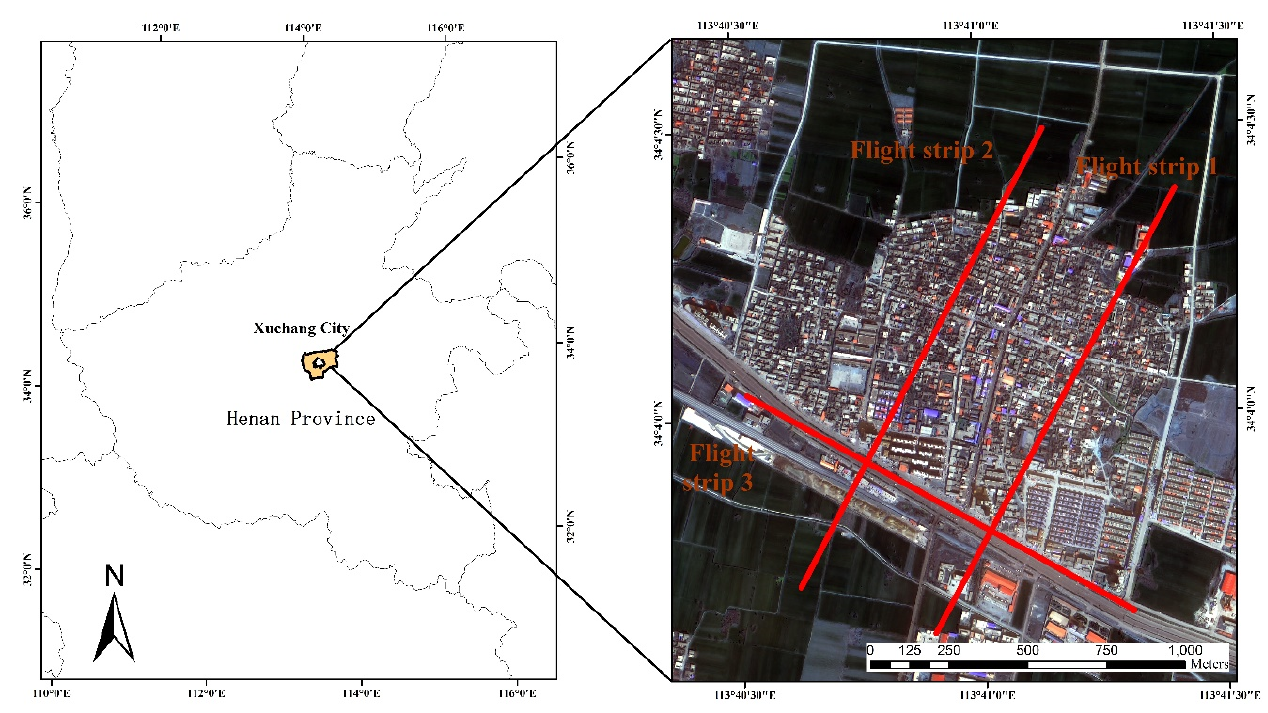
Figure 3. Location of the study area and flight strips.